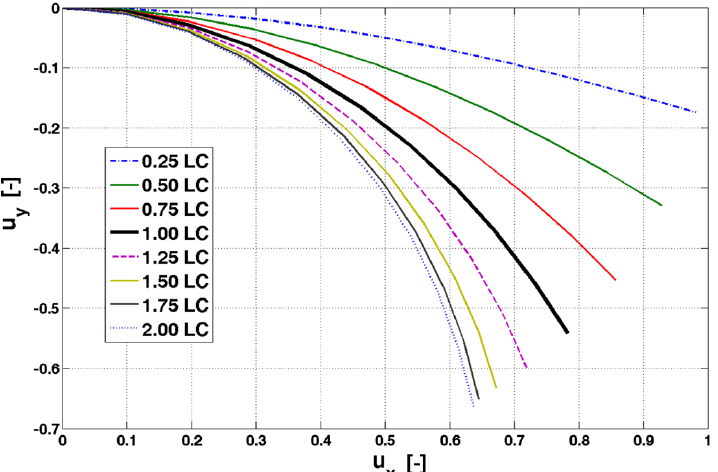
Figure 7. Trajectory position of the flexible joint subject to di ff erent load cases (LC) from presented method. LC: β = 0 . 663 [ − ], α = 1 . 137 [ − ] corresponds to F w = 73 . 5mN; L w = 14mm; I = 2 . 5 × 10 − 13 mm 4 ; E =